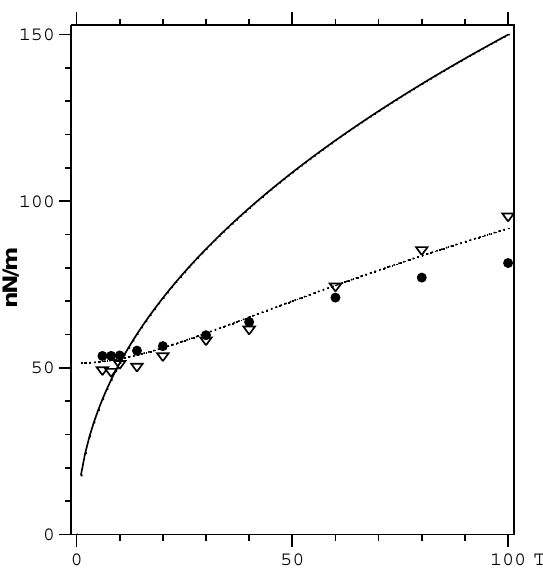
Fig. 9. Same as Fig. 6, but as function of solar wind electron tem- perature. Again, the dotted line is a version of Eq. (8) where T e was q T 2 e + ( 30eV ) 2 and the result multiplied by replaced by